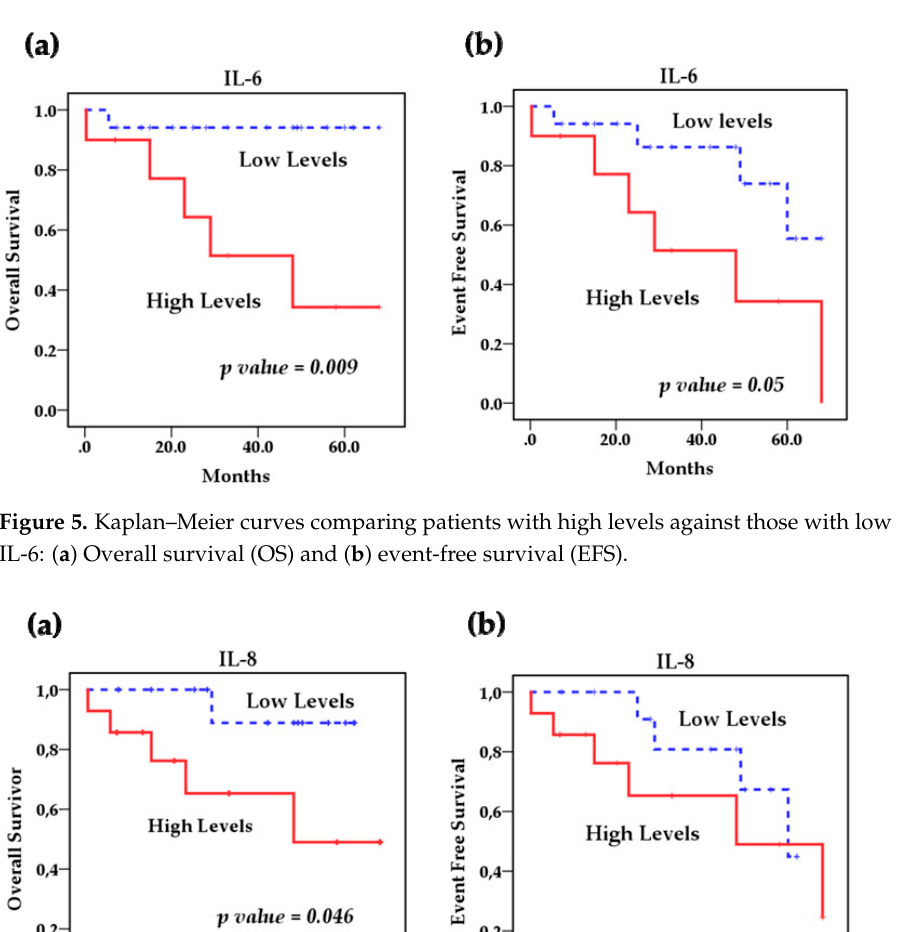
Figure 4. Kaplan–Meier curves comparing patients with the AA genotype against those with TT and TA genotypes of IL-8 SNP rs4073: ( a ) Overall survival (OS) and ( b ) event-free survival (EFS).